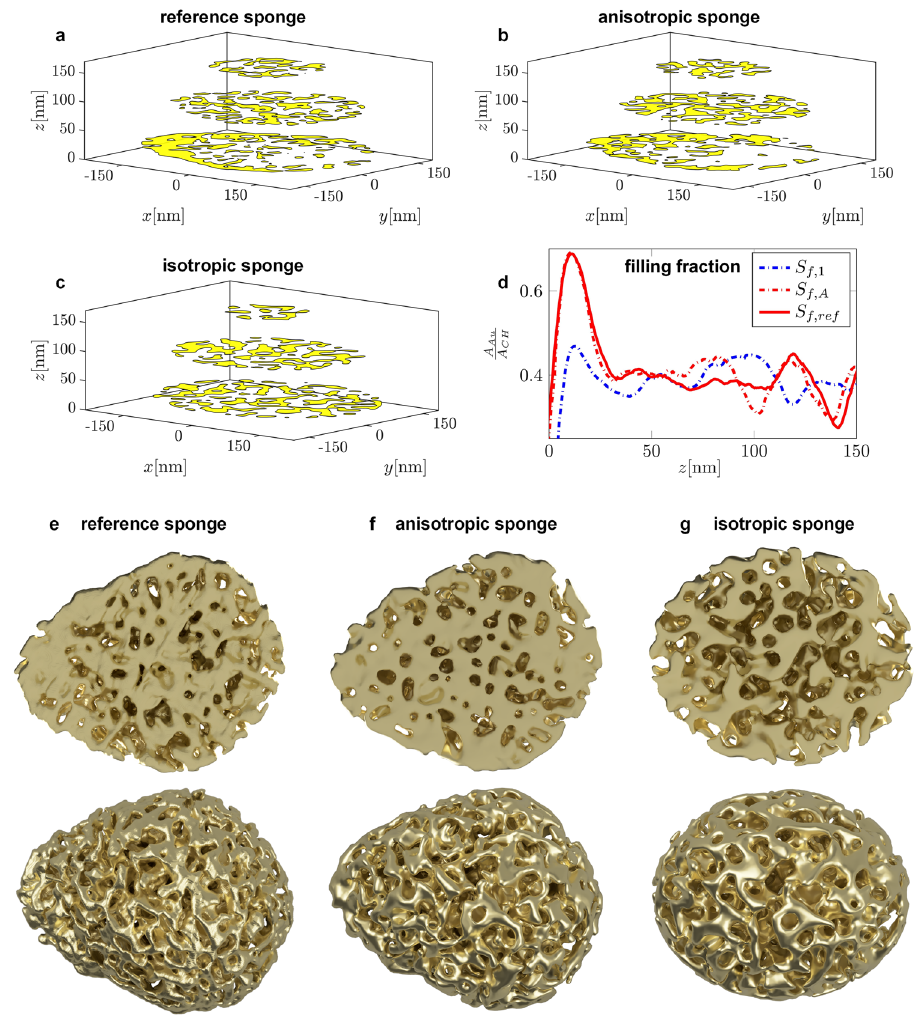
Fig. 7 Comparison of anisotropic properties of measured and computer-generated nanosponge geometries. a – c Plot of section planes through different sponges; a reference sponge S f , ref ; b simulated anisotropic sponge S f , A ; c simulated isotropic sponge S f ,2 ; d Plot of the areal density as a function of the slice position along the Z-axis for the different types of sponges. The areal density is de fi ned as the total area of all ligaments divided by the area of the convex hull for the given slice. It is evident that both S f , ref and S f , A are signi fi cantly thicker at the bottom compared to S f ,2 . e , f View from the top and bottom of the different sponges; e reference sponge S f , ref ; f anisotropic sponge S f , A ; g isotropic sponge S f ,2